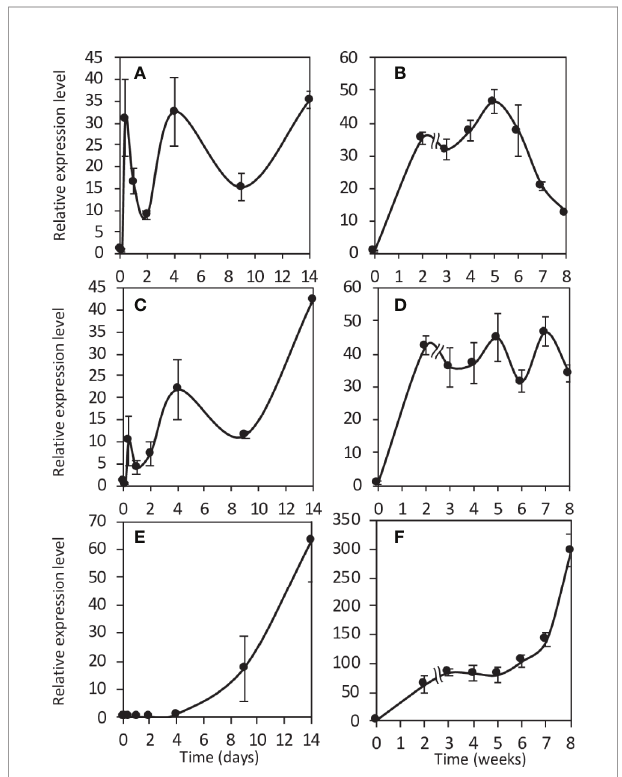
FIGURE 3 | Expression of Medicago truncatula NR genes during the symbiotic process. Expression analysis of the NR genes in roots and nodules during the symbiotic process. Short term kinetic 14 dpi (A, C, E) , long term kinetic 8 wpi (B, D, F) . Expression of NR1 (A, B) , NR2 (C, D) and NR3 (E, F) . Data are means ± SE of three biological replicates. Each measure was realized in three technical replicates. dpi, day post inoculation; wpi, week post